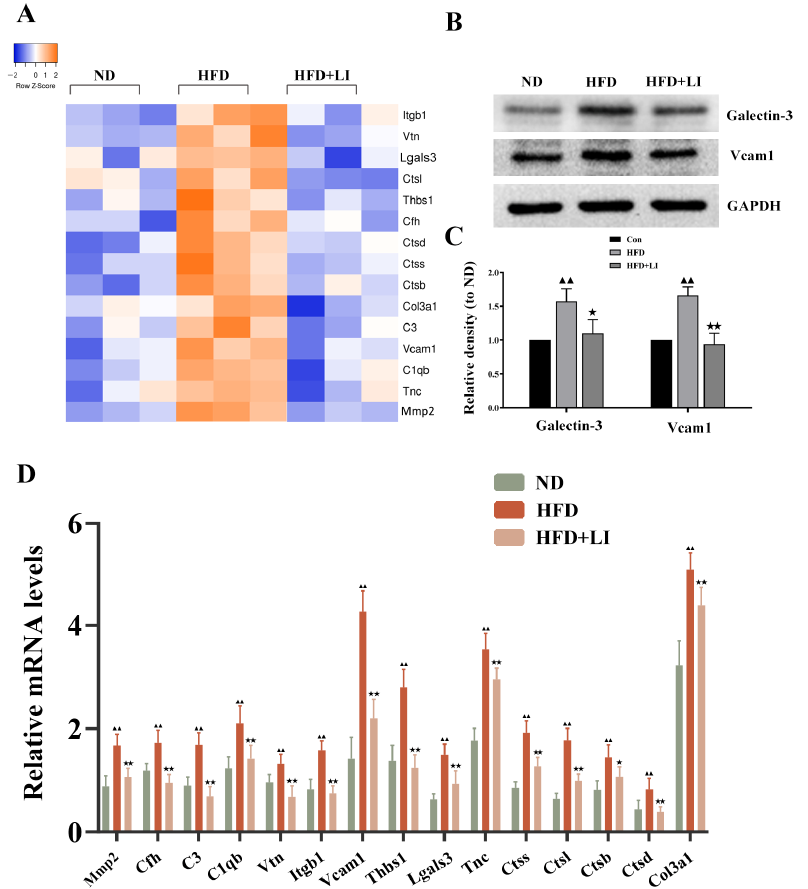
Figure 7. Validation of the differentially expressed proteins identified with the iTRAQ analysis and involved in aortic inflammation, vascular remodeling, and focal adhesion. ( A ) Heatmap of inflammation, vascular remodeling, and focal adhesion-related protein expression in aortic tissues in each diet group. ( B ) qRT-PCR analysis of the protein expression in aortic tissues in each diet group (n = 4). Data is presented as mean ± SD. Samples were pooled from three independent experiments. ( C ) Western blot detection of Galectin-3 (gene name: Lgals3) and VCAM1 protein expression in aortic tissue. ( D ) Quantification of protein expression presented as density relative to GAPDH. ▲▲ p < 0.01 vs. ND; ★ p < 0.05 vs. HFD; ★★ p < 0.01 vs. HFD. ND: normal diet-fed ApoE KO mice, HFD: high fat diet-fed ApoE KO mice, HFD + LI: high fat diet without iron supplementation-fed ApoE KO mice.